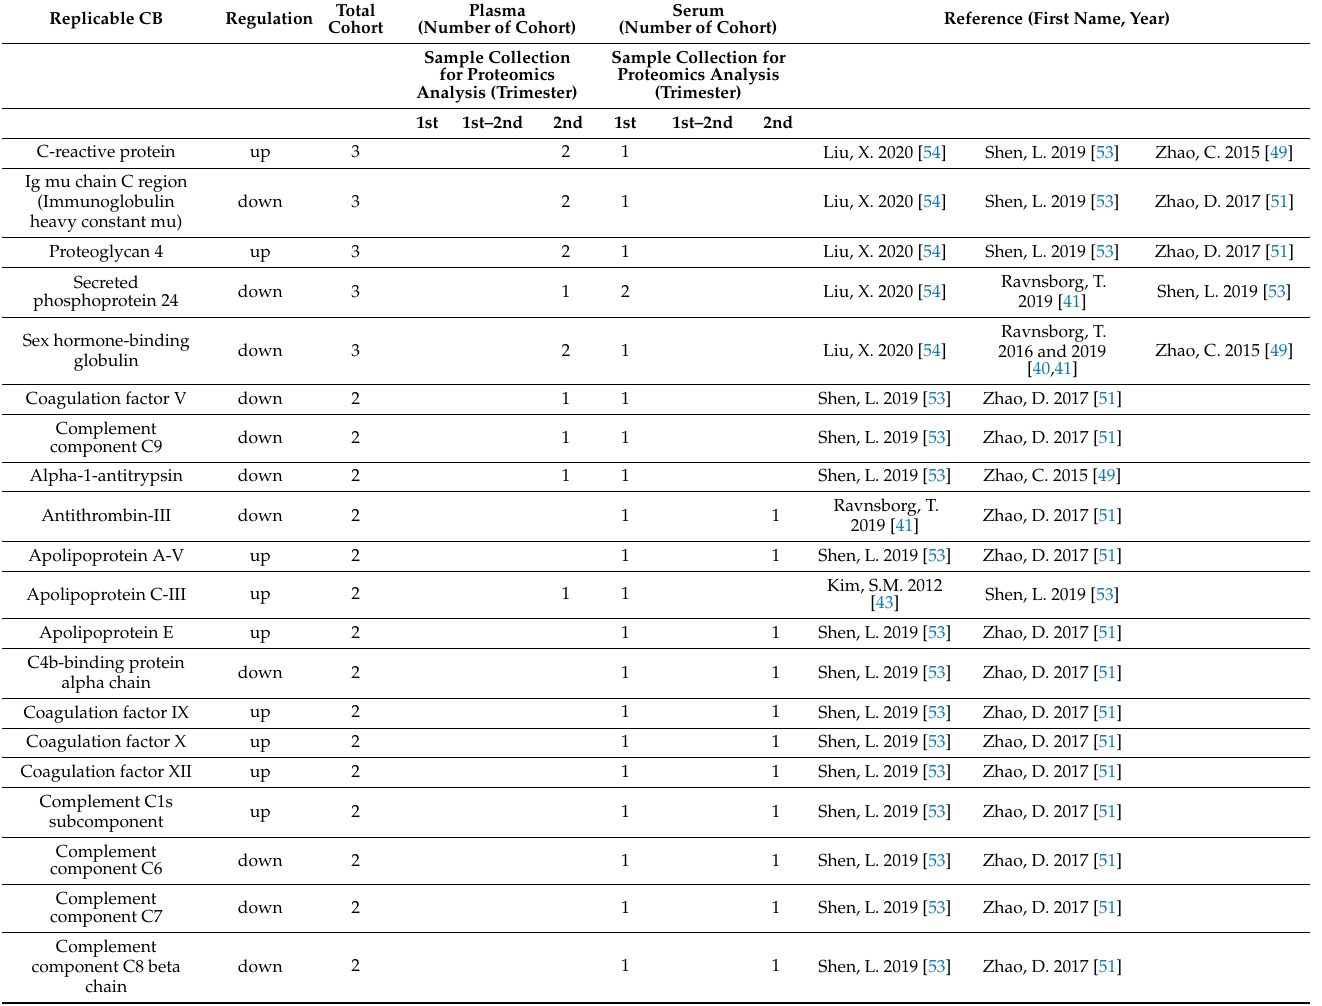
Table 1. Grouping of replicable candidate biomarkers (CBs) by blood fraction and collection